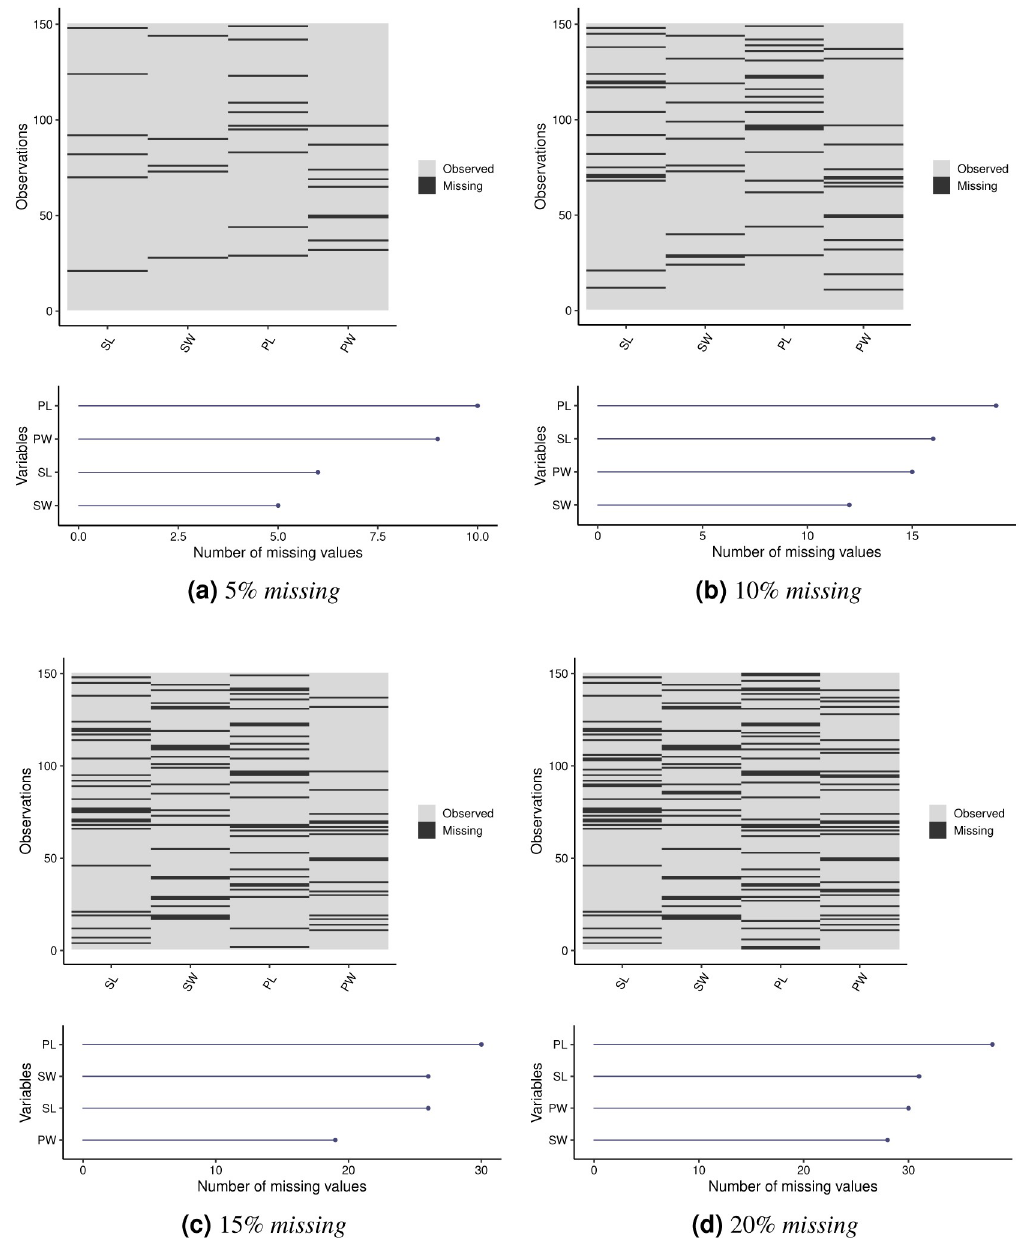
Fig 3. Visualizations of the patterns and frequencies of the missing values by variable for the Iris Plant dataset. ( a ) 5% missing . ( b ) 10% missing . ( c ) 15% missing . ( d ) 20% missing